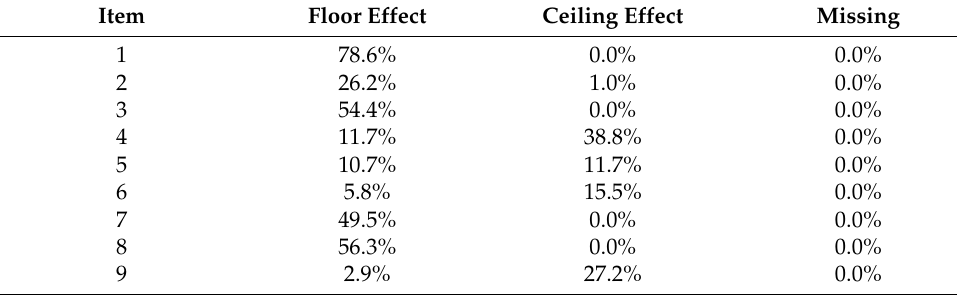
Table 3. Analysis of the individual questionnaire